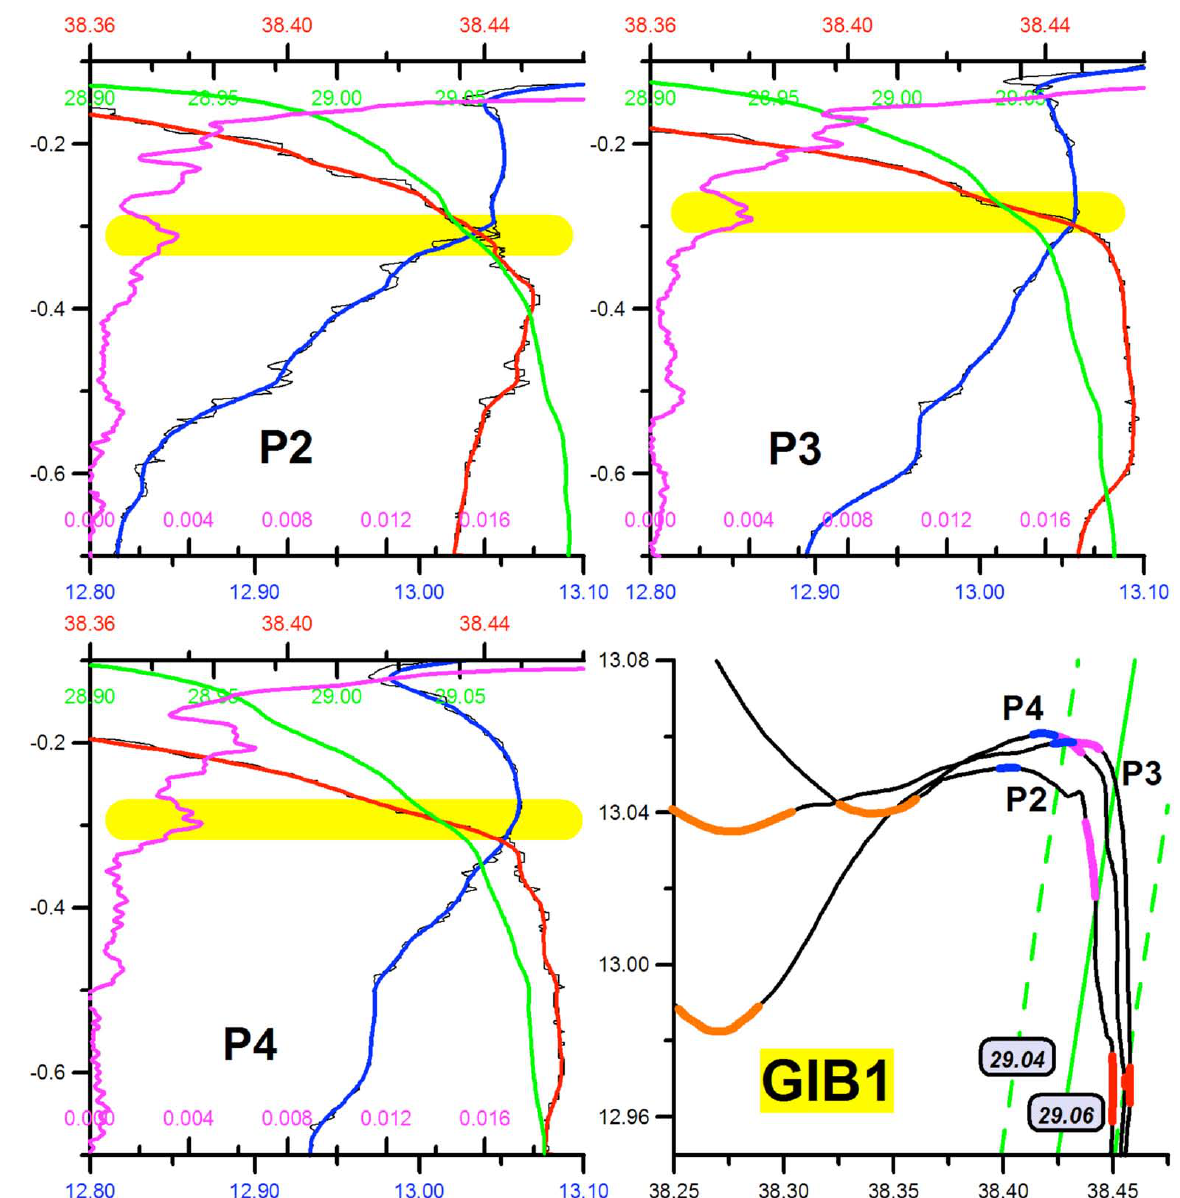
Fig. 4. – The thin black lines in the three sets of deepest and central profiles (from P2 in the south to P4 in the north) represent the raw data collected during GIB1 at 5°30’W (see Figure 3 of Millot (2013a)). Depths are in k-dbar. As specified in the text, smoothed q (blue) and S (red) profiles allowed the s (green) and d s /dz (pink) ones to be computed. In the q -S diagrams, the sets of the 10 extreme values for each parameter are specified in orange ( q intermediate minimum generally associated with the Western Intermediate Water), blue ( q intermediate maximum), red (S maximum) and pink (d s /dz maximum, as located by the yellow bars on the profiles, which we hypothetically associate with the LIW